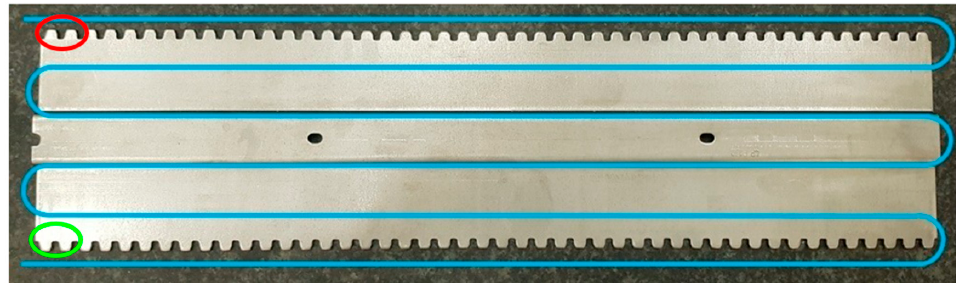
Figure 1. Female profile blank after tooth punching (the blue line shows the passage of the optical sensor in raster scanning mode) (own study).